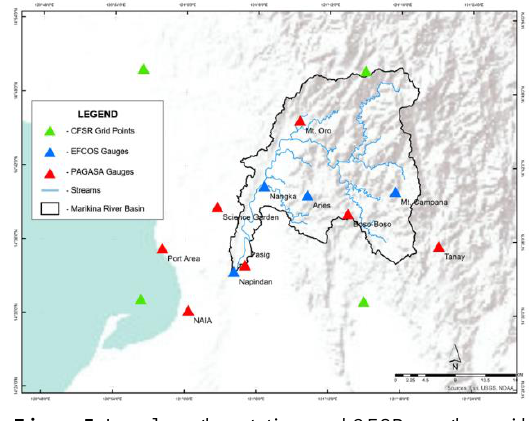
Figure 5. Local weather stations and CFSR weather grid points in the basin’s